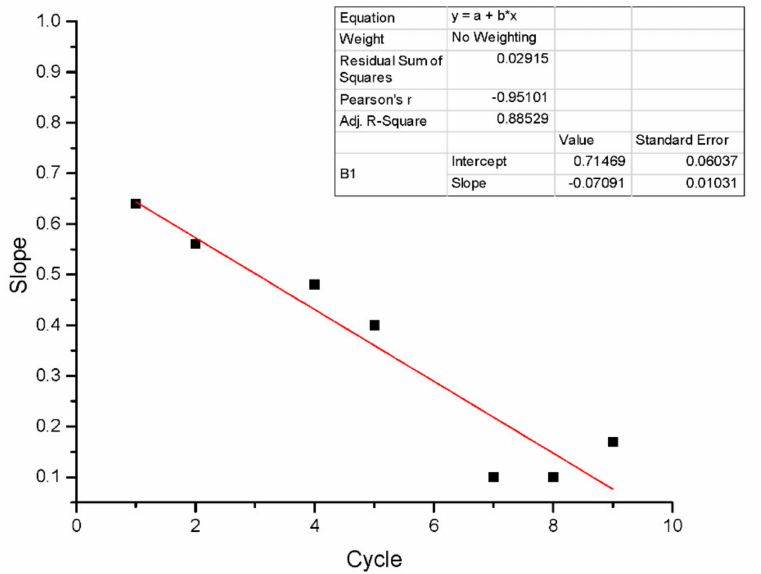
Figure 11. Denitrification performance running on subsequent